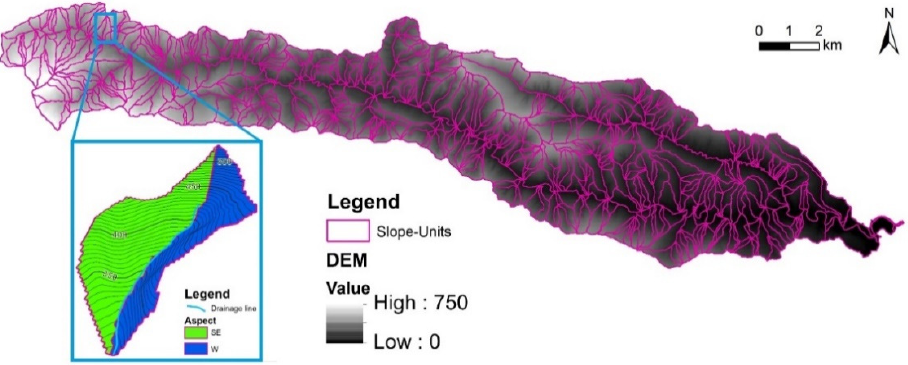
Figure 8. Subdivision of the basin in SUs with a detail of the segmentation process (in the inset, contour equidistance of 10 m).